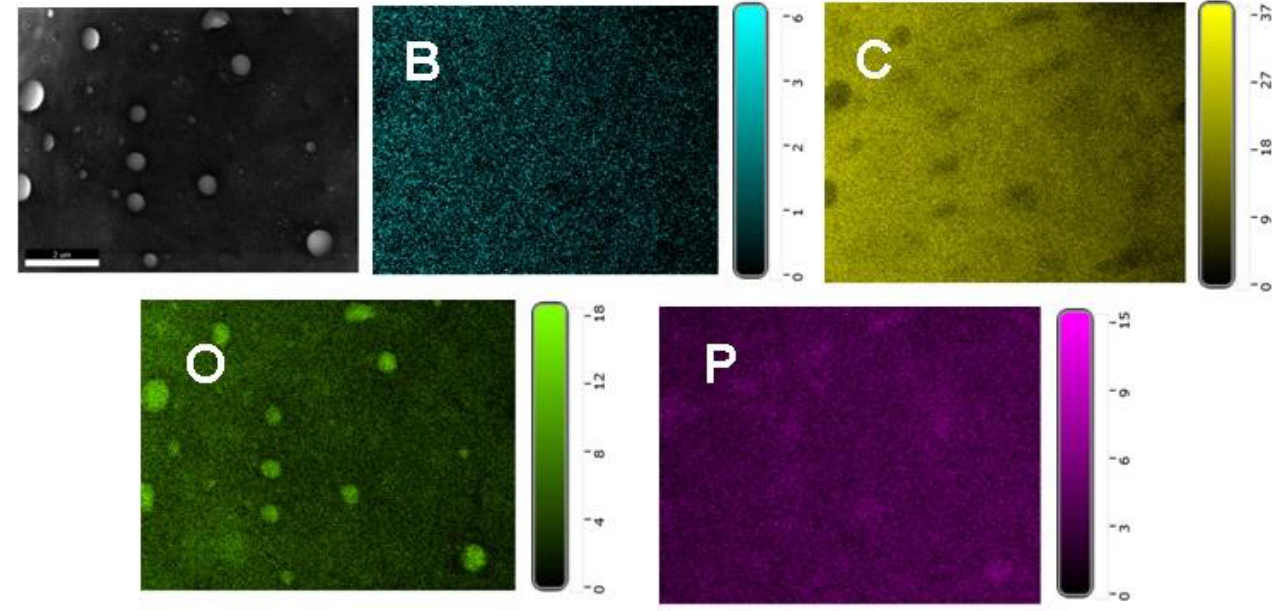
Figure 10. EDX mapping of EP-5 char.